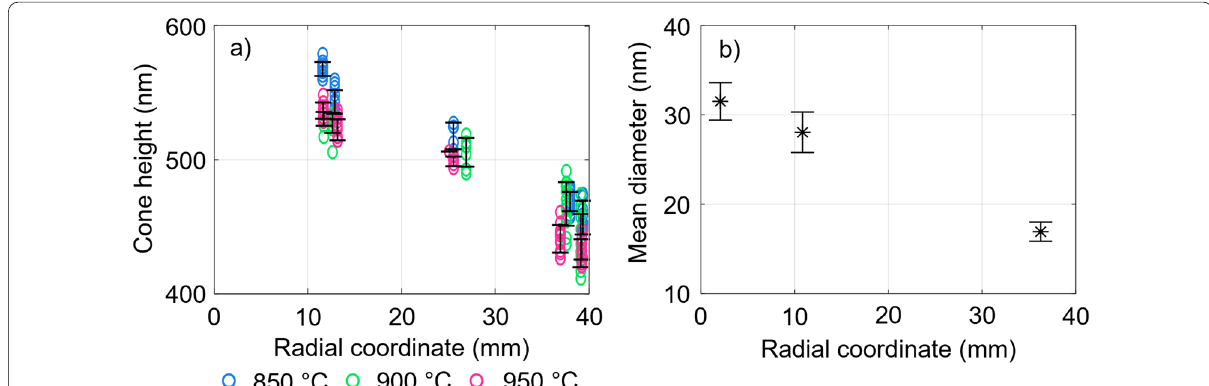
Fig. 8 a Interval plot of the measurements taken on the stripped SiNC heights, for three oxidation temperatures, measured at different radial coordinates as calculated with Eq. (1). A 95% CI is given with N 14 individual cones for the interval plots. b Interval plot of the mean diameter of = the top of the pre-shaped SiNC array before oxidation. The radial coordinates are calculated as shown in Eq. (1). The diameters are measured by an automated MATLAB script. The CI is given with N > 50 for individual